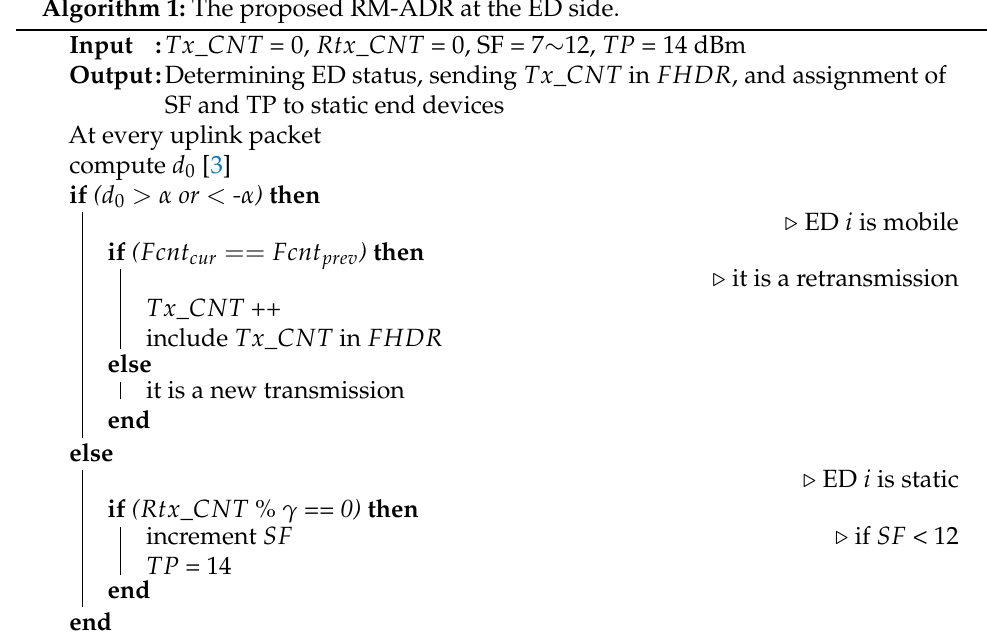
Algorithm 1: The proposed RM-ADR at the ED